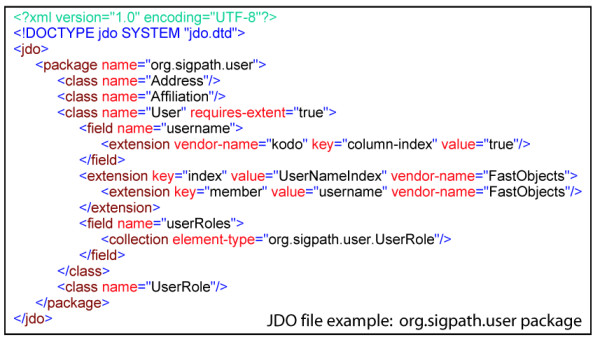
Example of JDO file. This file is used to define the persistent classes that are used in SigPath to represent end-users. Four persistent classes are shown: Address, Affiliation, User and UserRole. The <field> element can be used to refer to specific fields of persistent classes (such as the username field of class User on this example). The userRoles field is described to be a collection that contains elements of type UserRole. Elements called <extension> make it possible to provide vendor specific directives, such as to define indices on a persistent field.